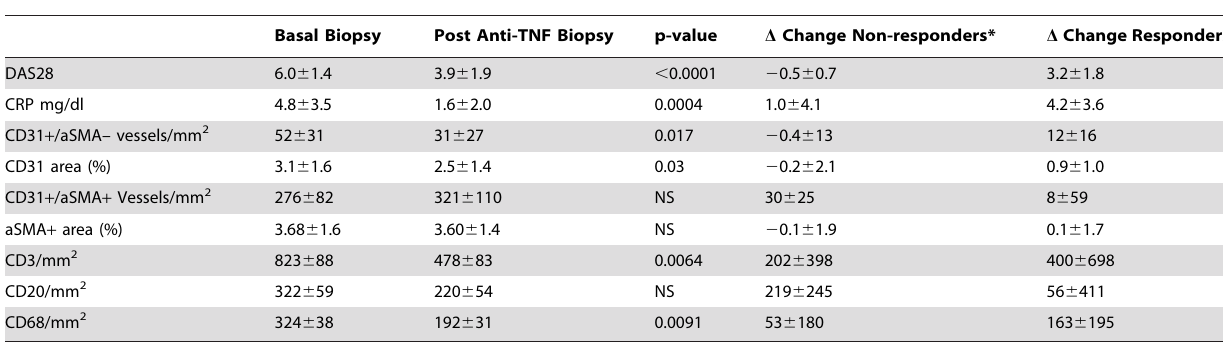
Table 3. Clinicopathological changes in patients after anti-TNF a